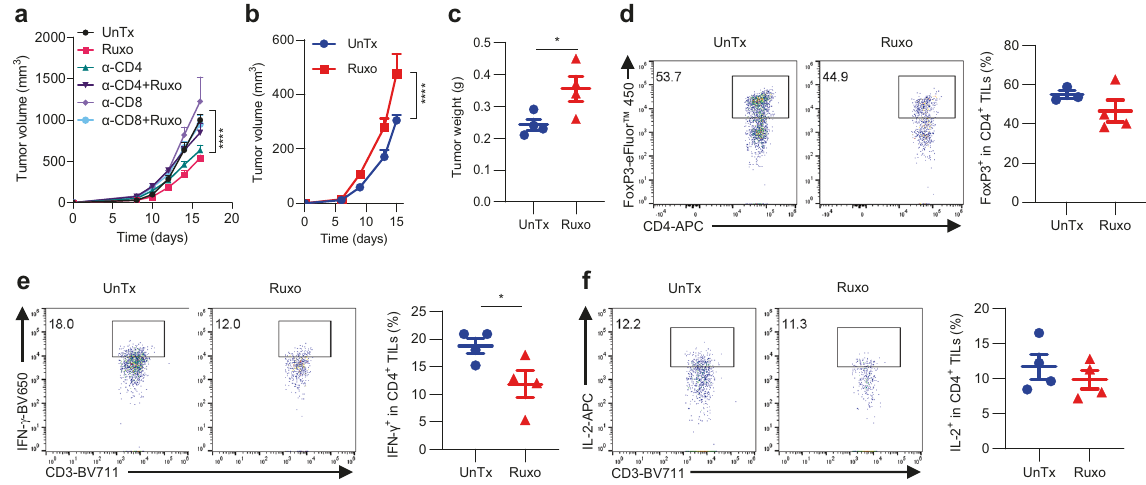
Fig. 7 | Ruxo-induced suppression of IFN γ R1 KO melanomas relies onT cells and host TNF. a Growth of IFN γ R1 KO melanomas in B6 mice treated with Ruxo, ±neu- tralizing antibodies against CD4 + ( α -CD4) or CD8 + ( α -CD8) T cells ( n =5 for UnTx, n =5forRuxo, n =10for α -CD4, n =10for α -CD4+Ruxo, n =9for α -CD8, n =5for α - CD8+Ruxo). **** p =0.00007 by two-way ANOVA with Tukey ’ s multiple compar- isons test (with adjustment). b – f TNF − / − mice bearing IFN γ R1 KO melanoma were treated with vehicle (UnTx, n =4) or Ruxo ( n =4) (90mg/kg by oral gavage twice daily) for 10 days. b Tumor growth (*** p =0.0007 by two-way ANOVA with Š ídák ’ s